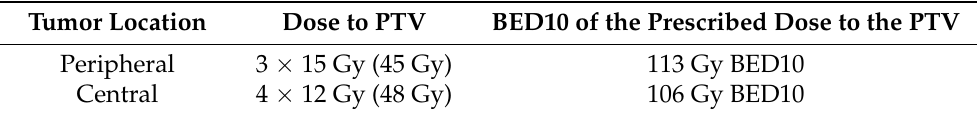
Table 3. SBRT doses and fractionations for lung lesions according to the ESTRO ACROP consensus on the implementation and practice of SBRT for peripheral lesions in early-stage non-small-cell lung cancer.